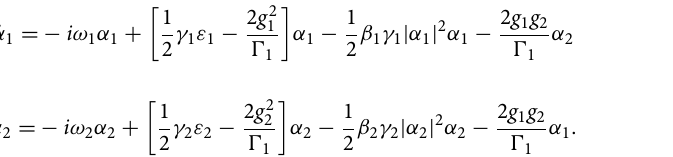
frequencies ω ′ 1 = 0.2 γ 1 , ω ′ 2 = ω ′ 1 + �ω = 0.21 γ 1 and � ′ 1 = ω ′ 1 = 0.2 γ 1 , which are lower than those Fig. 1. As we